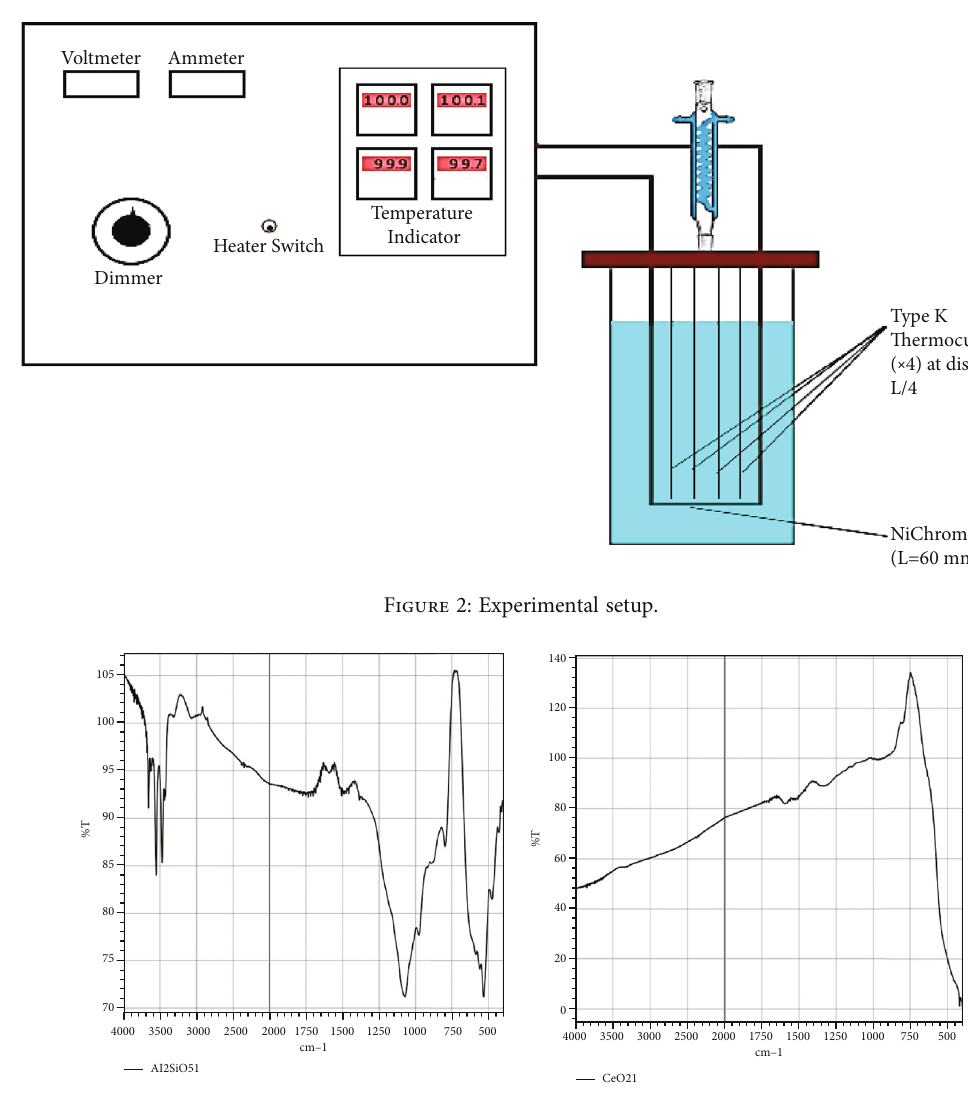
SiO nanoparticle and (b) C 2 5